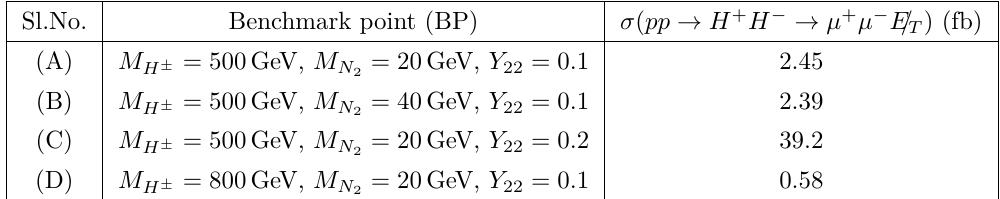
Table 6 . Production cross-section of the dimuon + /E T final state generated from intermediate inert charged Higgses. This production is exclusively for Toy Model I.